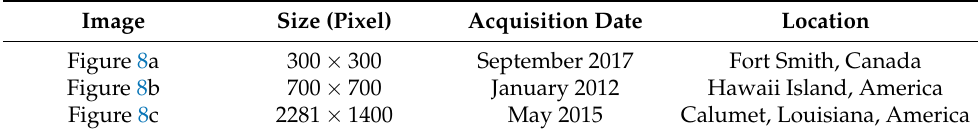
Table 1. Descriptions of three PolSAR data items for line